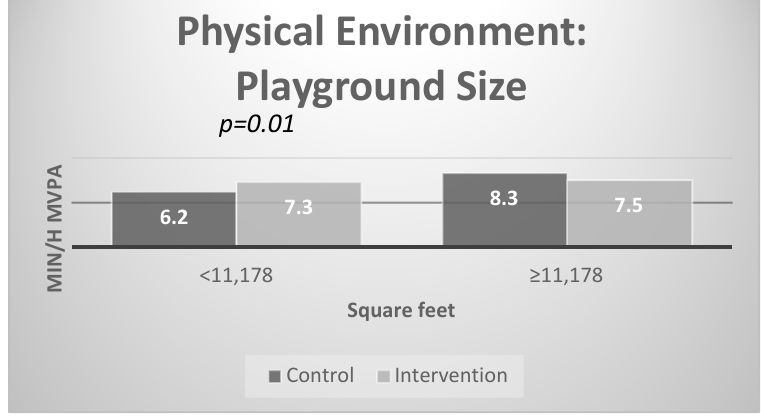
Figure 3. Interaction effects with social environment based on the Early Childhood Environment Rating Scale-Revised Edition (ECERS-R) scale subset.